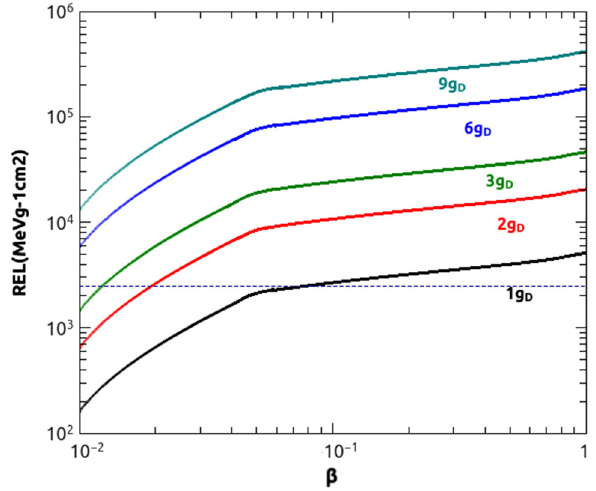
Fig. 3 Restricted energy loss in Makrofol for monopoles of different magnetic charge. The horizontal dashed line indicates the Makrofol detection threshold